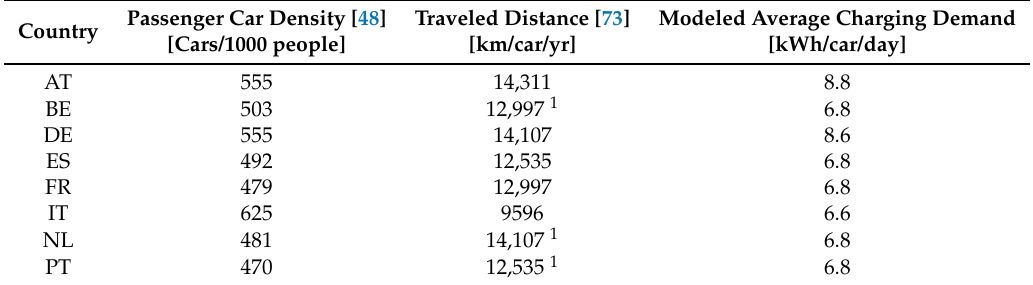
Table A4. Key numbers of mobility pattern in the selected countries.